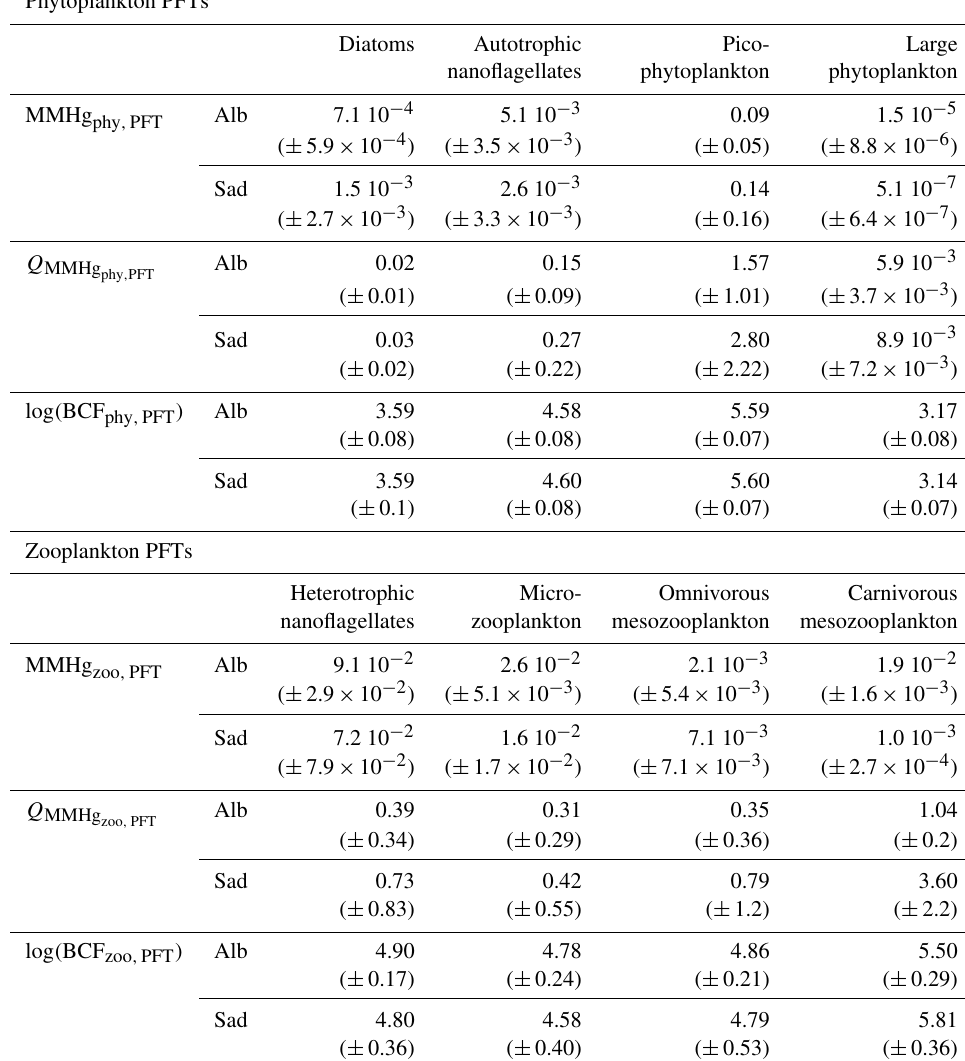
Table 1. Indicators for MMHg bioaccumulation compared for the Alb and Sad subbasins (Fig. 3). The average ( ± SD) values of the plankton MMHg content (MMHg PFT , pmolm − 3 ), the MMHg quota ( Q MMHg , PFT , ngg − 1 w . w . ), and the bioconcentration factors (log ( BCF PFT ) ) are shown for each phytoplankton and zooplankton